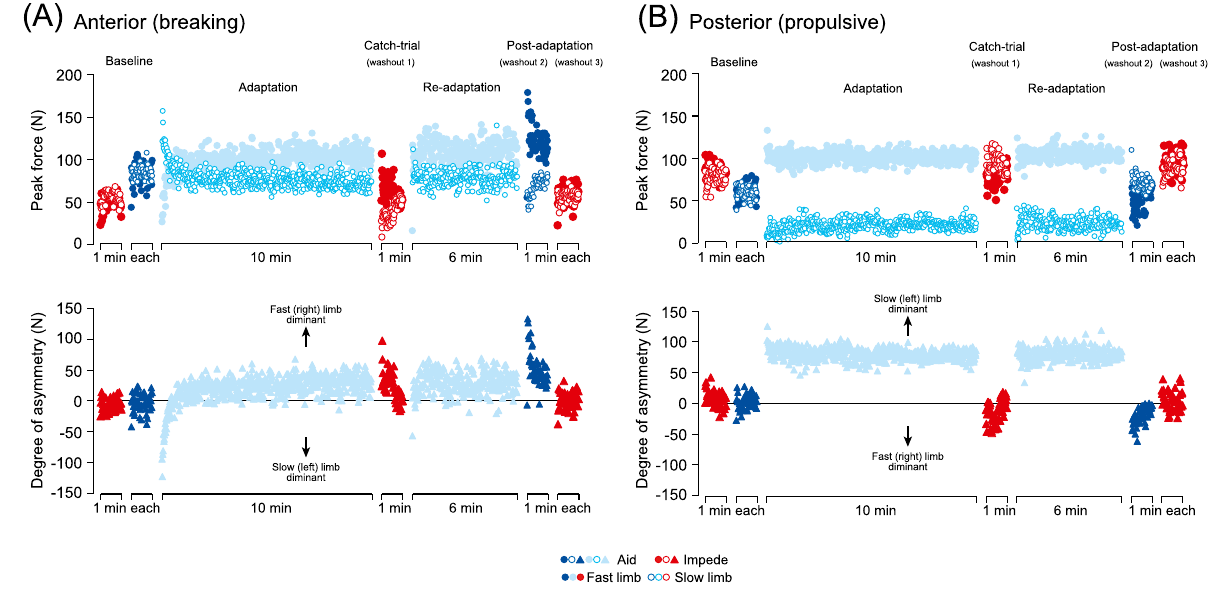
Figure 3. (Upper panels) Example of typical time-series changes in the peak amplitude (absolute values) of the braking ( A ) and the propulsive ( B ) component of the GRF on a stride-by-stride basis in a single subject (same subject as in Fig. 4) from Experiment 2 (split-belt adaptation with aiding force field) for both the fast (filled circle) and slow (open circle) sides. (Lower panels) The differences in the peak forces between the fast and slow sides (degree of asymmetry) for each stride cycle.